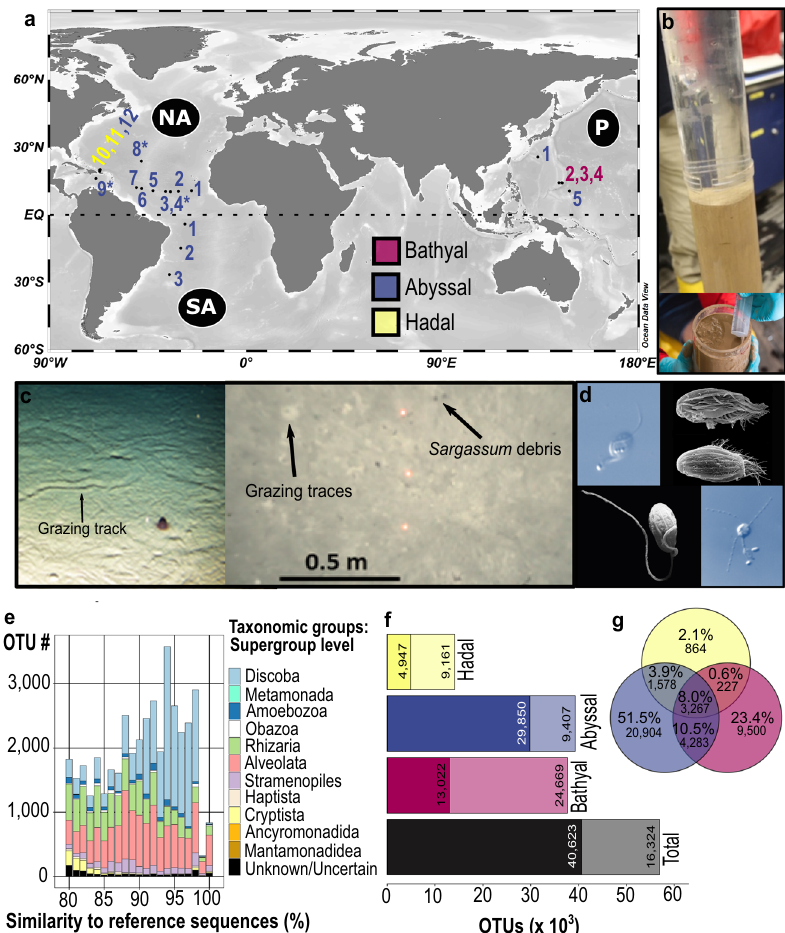
Fig. 1 Heterotrophic deep-sea protist diversity and distribution. a Map of the 20 examined deep-sea stations. Multiple sediment samples were analyzed separately at stations marked with an asterisk for the investigation of small-scale distribution patterns. In the North Atlantic Ocean (NA) samples were collected during two expeditions (one in summer marked with asterisk, one in winter marked with dots, map created with Ocean Data View 27 ). b Only the upper 2 mm of undisturbed sediment from cores of the Multi-Corer were taken with a sterile syringe. c Images from the abyssal sea fl oor showing small- scale heterogeneity including grazing tracks and traces (e.g., polychaetes, holothurians), and Sargassum debris (© Nils Brenke, Nico Augustin, GEOMAR Kiel). d Observed deep-sea fl agellates Rhynchomonas nasuta (upper left), Euplotes dominicanus (upper right 29 ), Keelungia nitschei (lower left 56 ), and Massisteria marina (lower right). e Similarity of heterotrophic protist rDNA richness (~22% of the total un fi ltered OTUs) to total referenced eukaryotic rDNA diversity in the V9_DeepSea database. Proportion of OTUs per taxonomic group (corresponding to supergroups in the PR2 database classi fi cation) is color-coded. “ Unknown/Uncertain ” OTUs have been either assigned to several taxonomic division levels or to sequences taxonomically assigned only to Eukaryota. f Observed (dark colored) and estimated (light colored) OTUs based on the Incidence Coverage Estimator (ICE). g Venn diagram showing the number of unique and shared OTUs between the three different depth